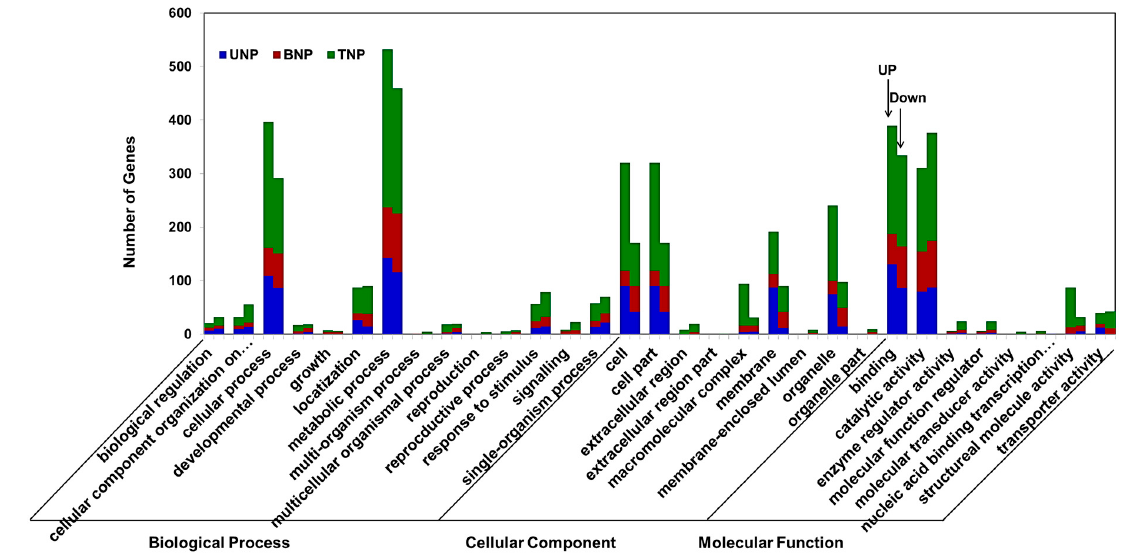
Figure 4. Gene Ontology (GO) classifications of differentially abundant proteins (DAPs) in KTM3315A and TM3315B during the three stages. The x -axis represents each GO term and the y -axis shows the number of enriched DAPs in each main category. “Up” represents upregulated DAPs and “down” represents downregulated DAPs. In terms of each GO term, the column on the left shows the number of upregulated DAPs and the column on the right is the number of downregulated DAPs.